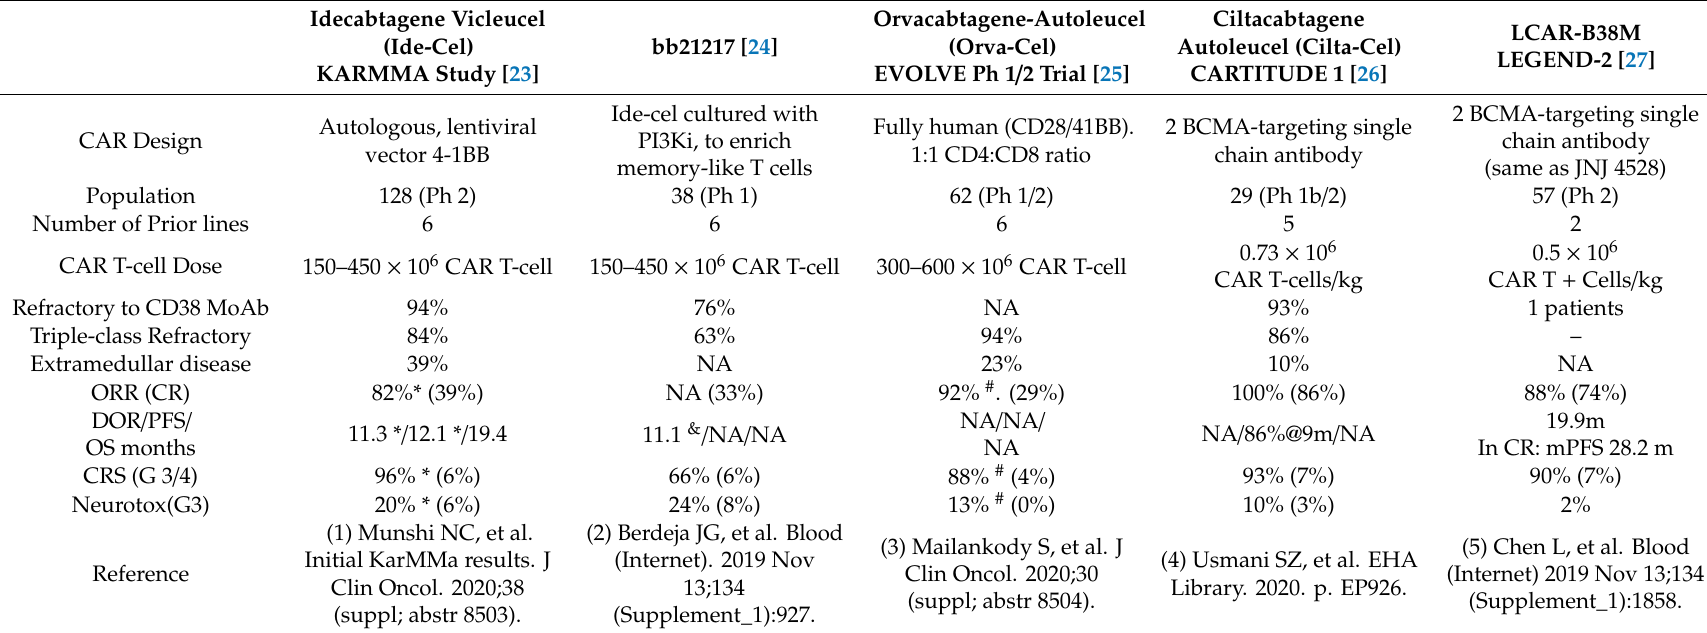
Table 2. Summary of efficacy and safety of most relevant B-cell maturation antigen (BCMA)-directed CAR T-cell trials in relapse and refractory multiple myeloma